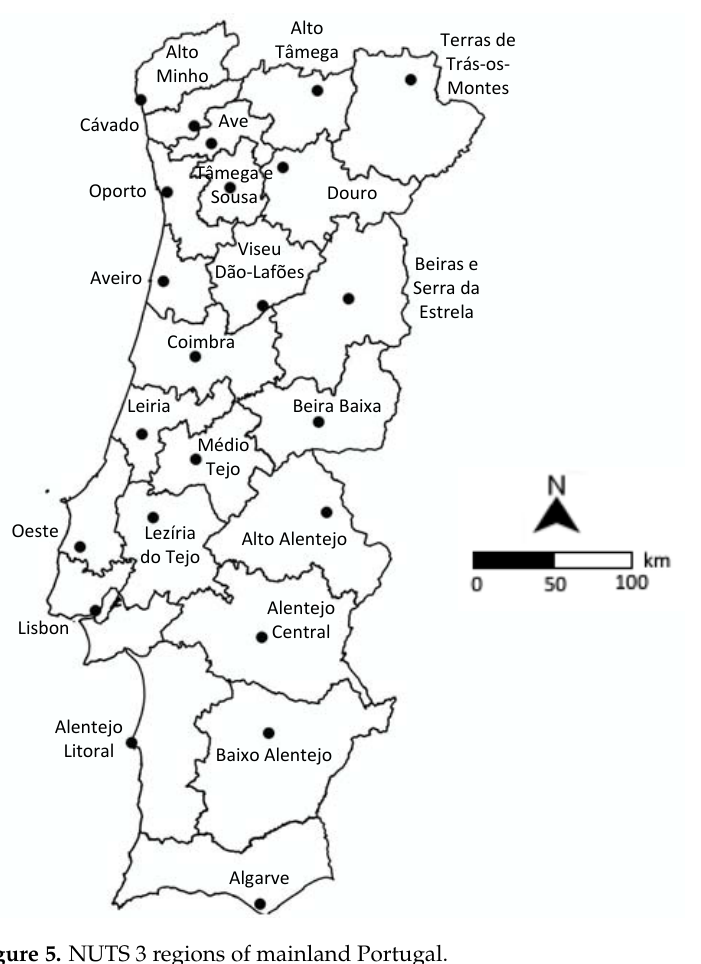
Figure 5. NUTS 3 regions of mainland Portugal.